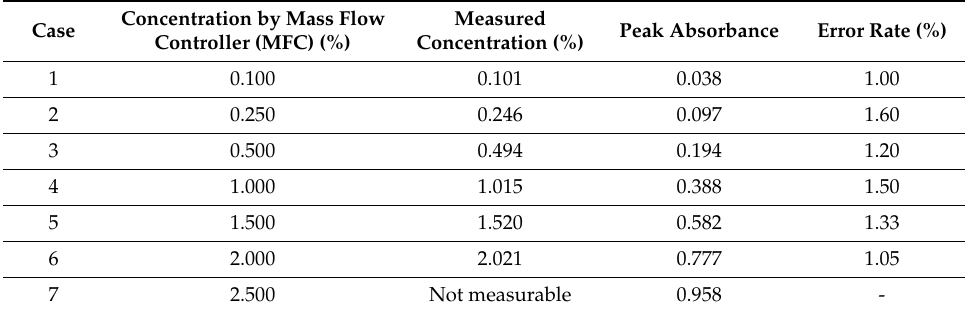
Table 2. Results of carbon monoxide (CO) concentration and detection limit range for the preliminary